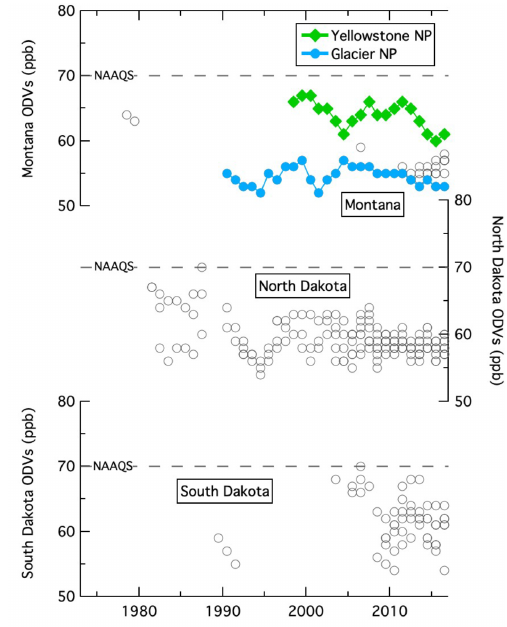
Figure 4. Time series of all ODVs (grey symbols) reported from all monitoring sites in three rural western states plus Yellowstone NP, located in Wyoming. The two sets of colored symbols are results from two long-term sites in national parks. Table 1. ODV statistics from the rural western states. State or